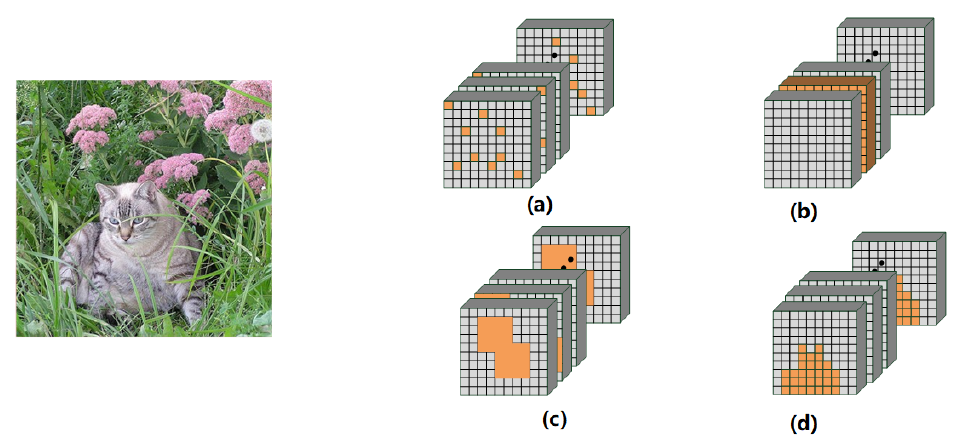
Figure 1. Four forms of dropout in CNN. ( a ) Dropout randomly drops units on each channel. However, it does not work well on CNN. ( b ) SpatialDropout randomly drops channel instead of units. ( c ) DropBlock randomly drops some contiguous regions inspired by Cutout. ( d ) Some non-random dropout methods discard influential units. The orange neurons, channels and contiguous regions present the discarded parts, and the gray will be